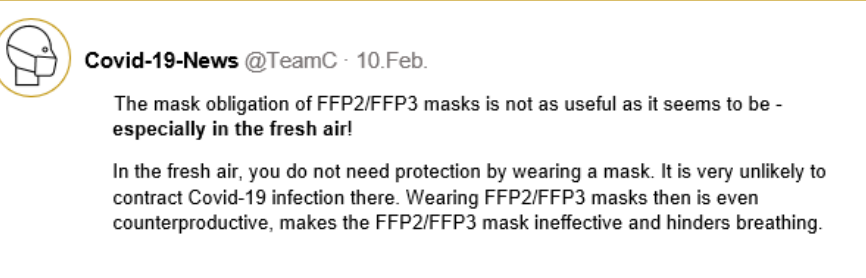
Figure A5. Conspiracy-theoretical Posting Team C Note. Predictor media content: conspiracy-theoretical Posting Team C. Originally presented in German. Translation; “Die Maskenpflicht von FFP2/FFP3-Masken ist nicht so sinnvoll, wie sie zu sein scheint—vor allem an der frischen Luft ! An der frischen Luft benötigt man keinen Schutz durch das Tragen einer Maske. Es ist sehr un- wahrscheinlich sich dort an einer Covid-19-Infektion anzustecken. Das Tragen von FFP2/FFP3- Masken ist dann sogar kontraproduktiv, macht die FFP2/FFP3-Maske unwirksam und behindert die Atmung”.